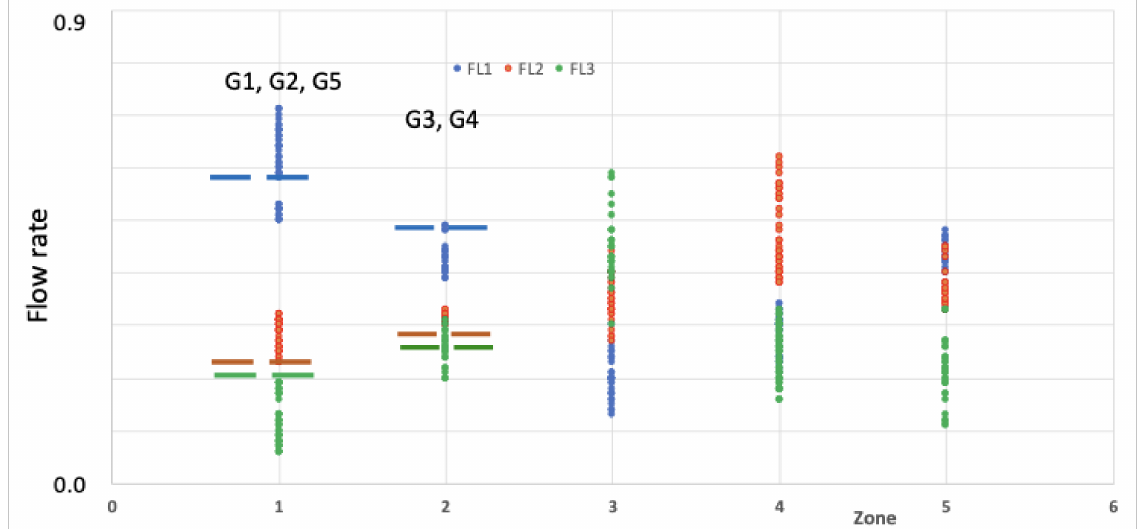
Figure 22. Localization of the leakage events (G1 to G5) on the